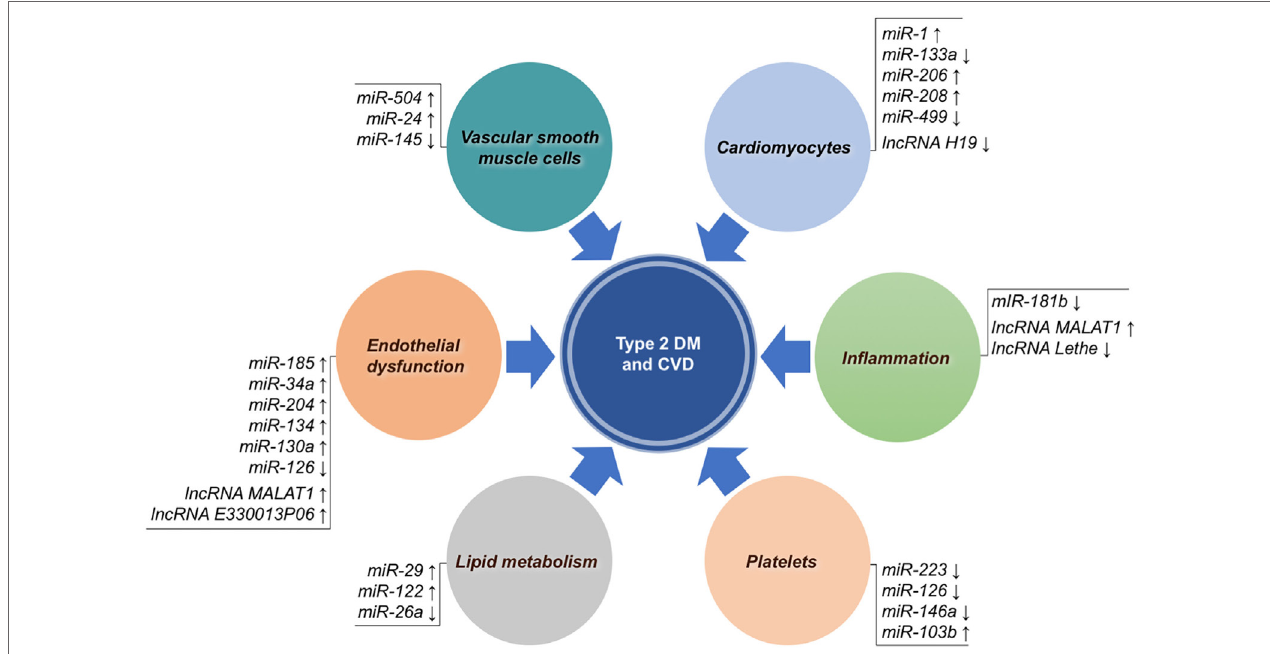
FiGURe 1 | Non-coding RNAs associated with both type 2 diabetes mellitus (DM) and cardiovascular disease (CVD). MicroRNAs (miRNAs) and long non-coding RNAs (lncRNAs) are grouped according to their main biological mechanism involved in atherosclerotic CVD. Arrows indicate overexpression ( ↑ ) or underexpression ( ↓